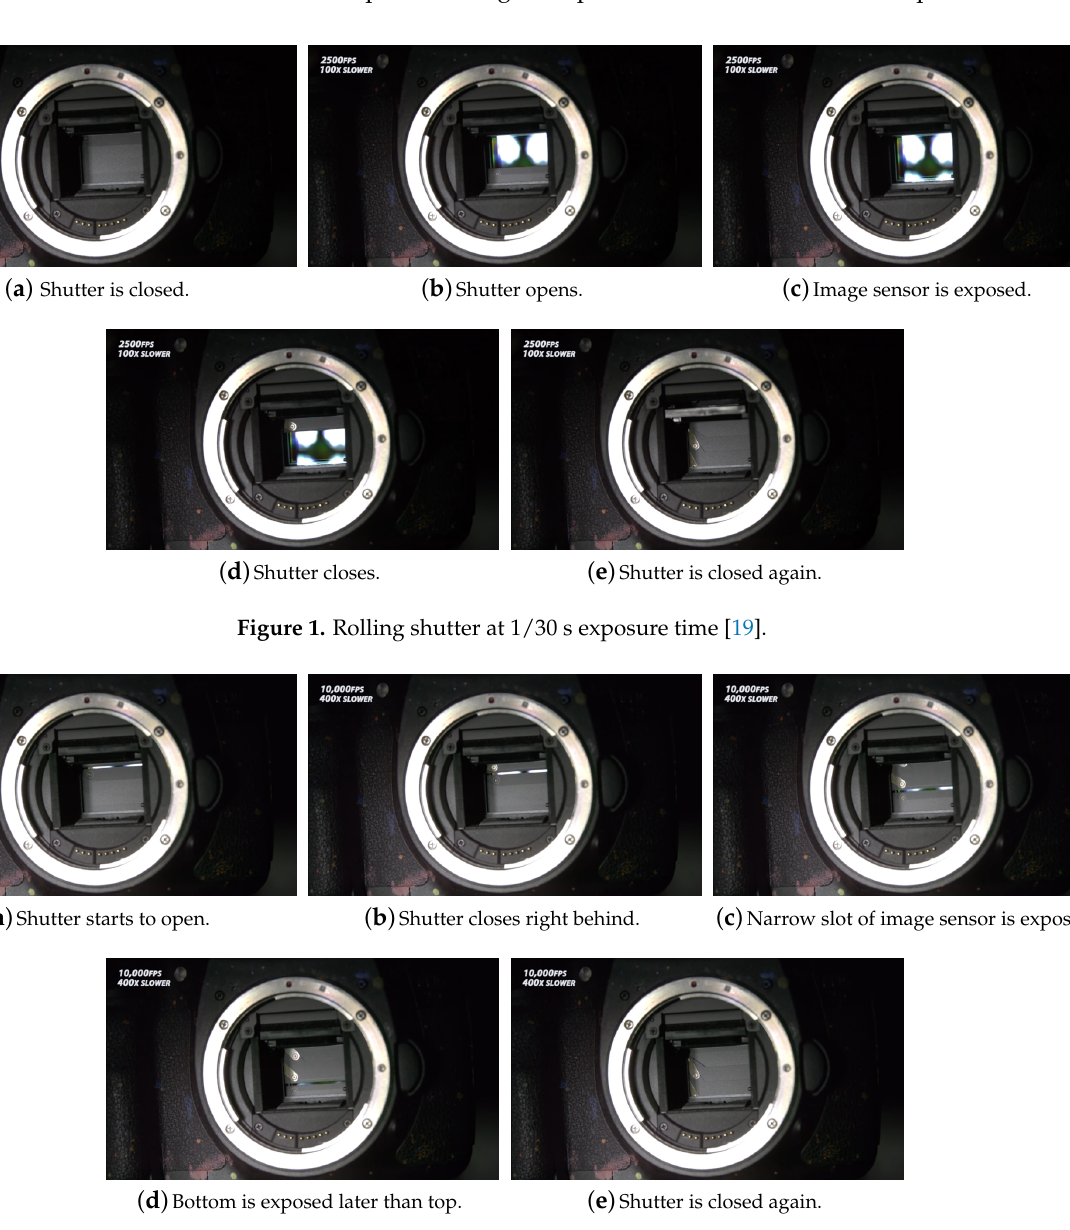
Figure 2. Rolling shutter at 1/8000 s exposure time